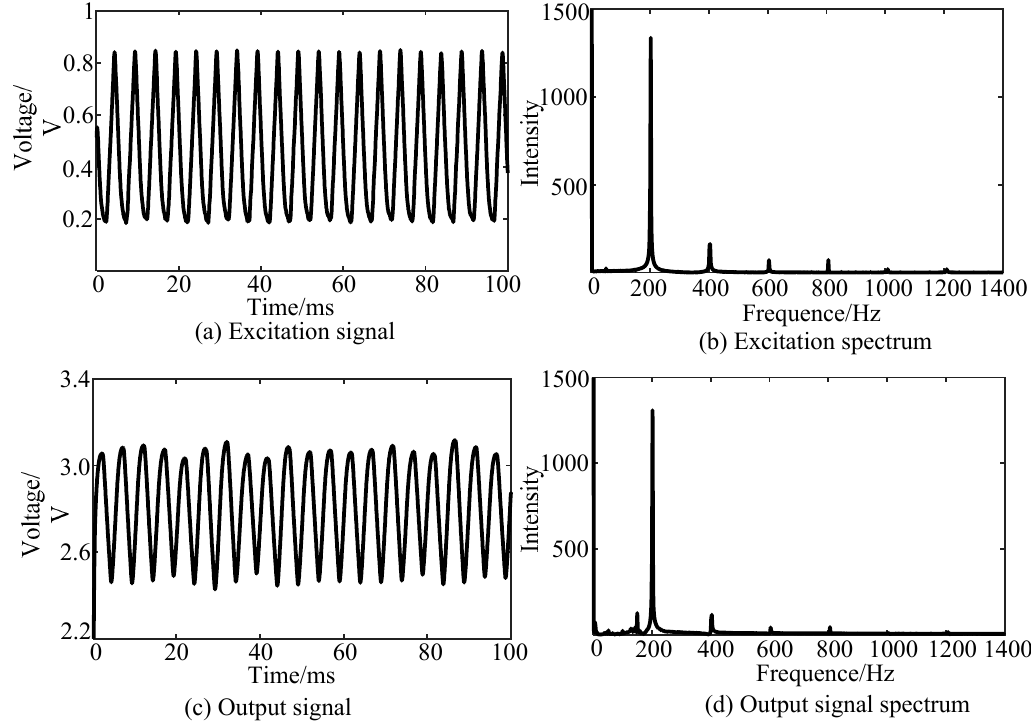
Figure 6. Time-domain and frequency-domain waveforms of the experimental signals at 200 Hz. They are: ( a ) excitation signal; ( b ) excitation spectrum; ( c ) output signal; ( d ) output signal spectrum.